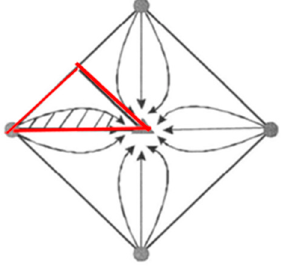
Figure 8. Five-point well network.